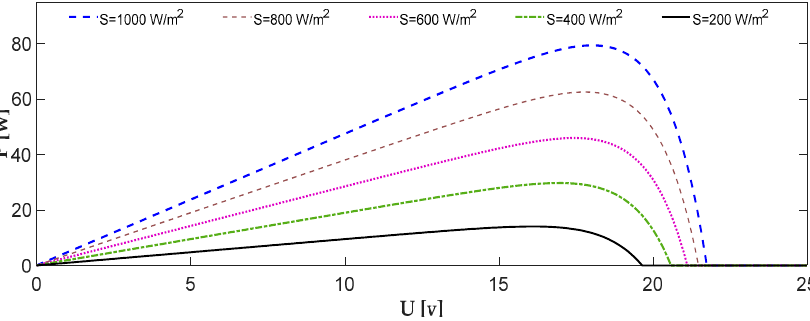
Figure 7. P–V (output active power versus voltage) curves of photo-voltaic cells at T = 25 °C.